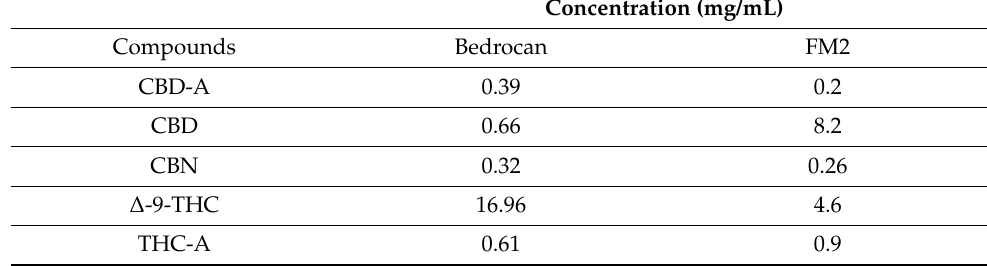
Table 1. Cannabinoid compounds identified in Bedrocan and FM2 extracts.